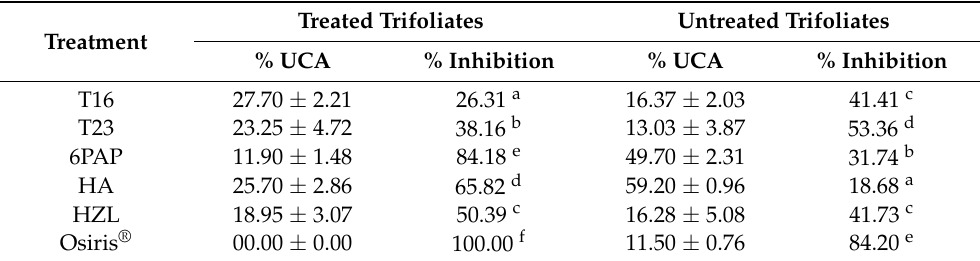
Table 3. Influence of Trichoderma strains and their secondary metabolites on ASR development on treated and next upper, untreated trifoliates. Treated Treatment